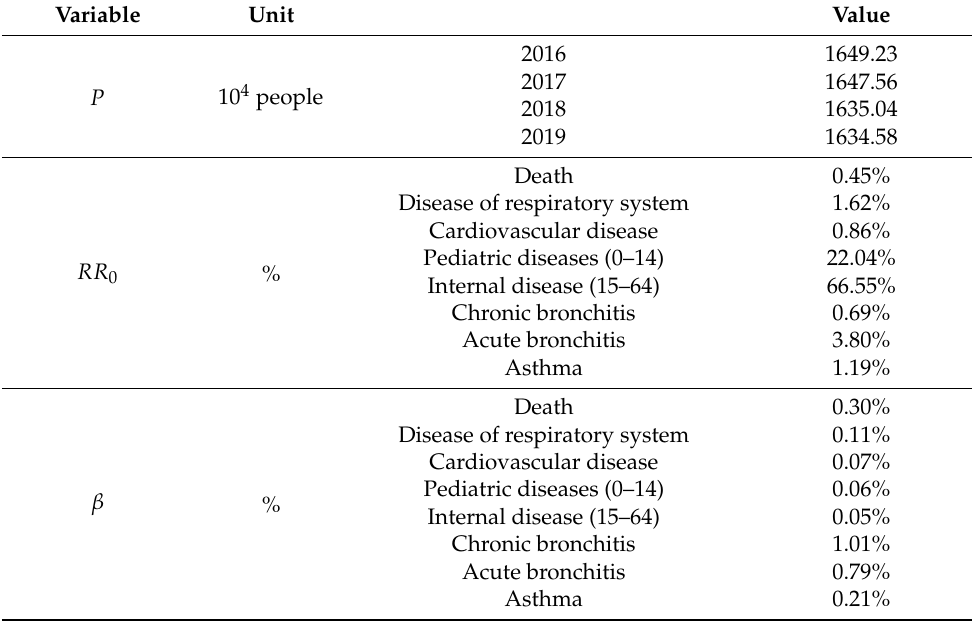
Table 1. Data of variables in exposure-response model.